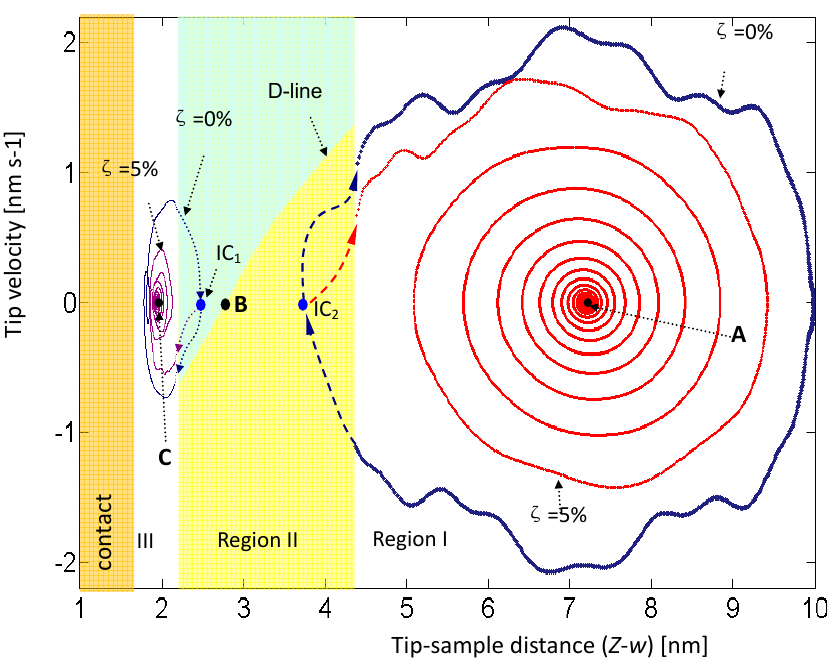
Figure 7. Phase portrait of tip under free vibration with two tip initial conditions and various damping